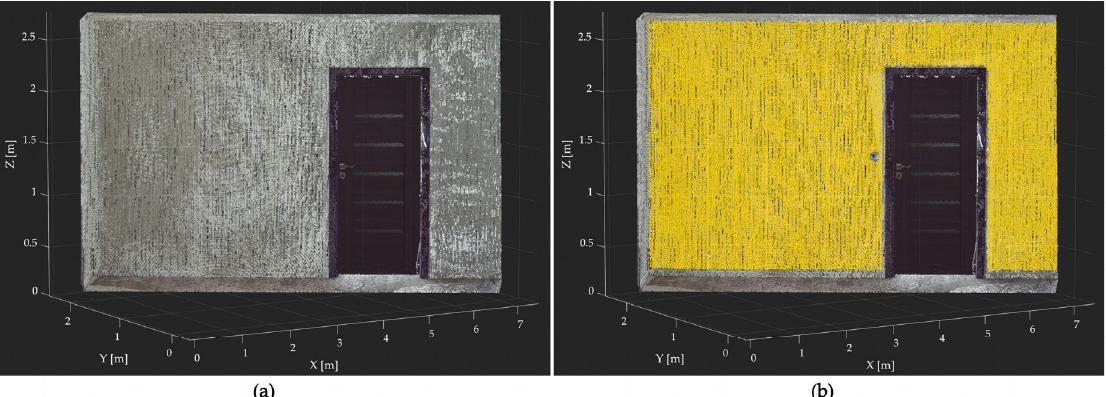
Figure 5. Point cloud segmentation: ( a ) the initial point cloud; ( b ) the result of plane segmentation, the inliers for the selected wall’s plane.